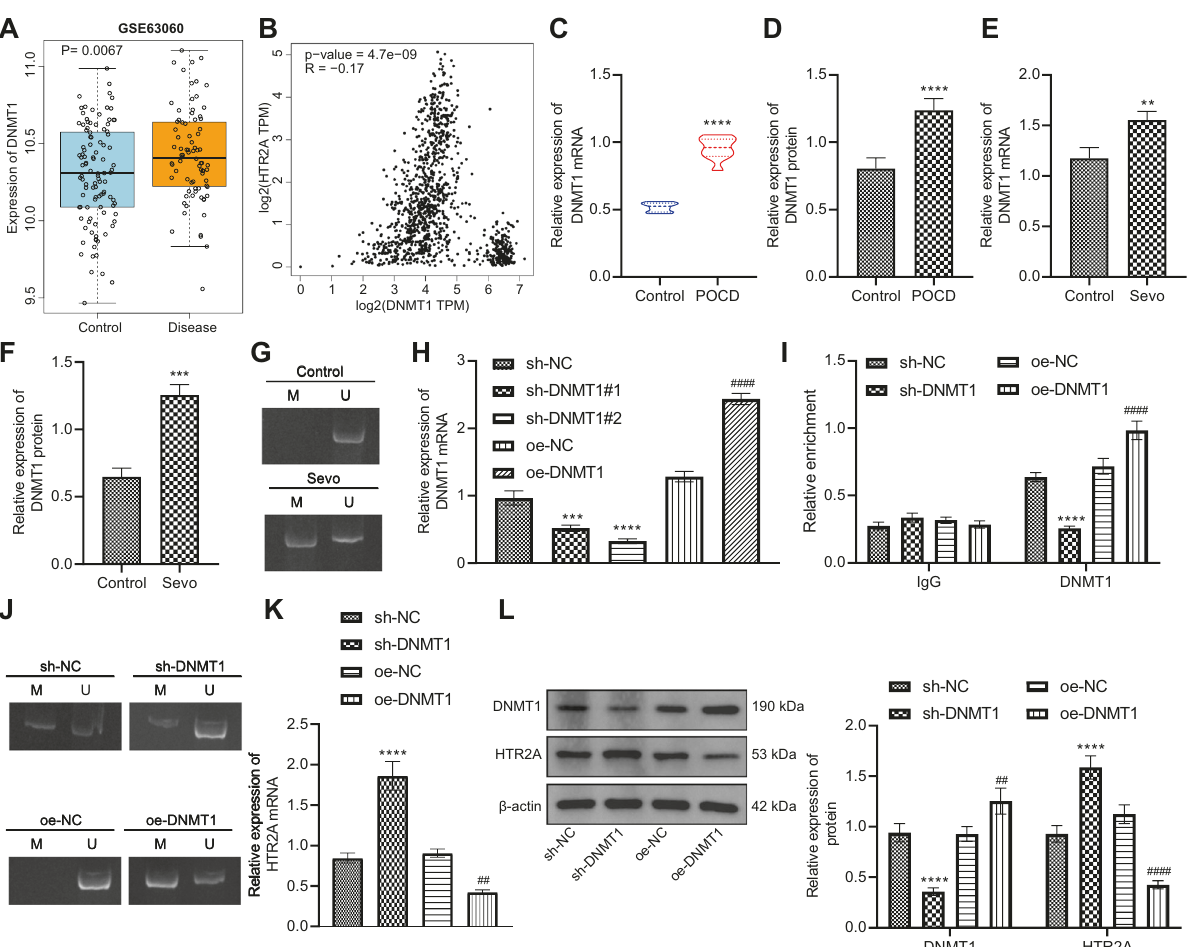
Fig. 4 DNA methyltransferase DNMT1 induces HTR2A methylation to repress its transcription in hippocampal neurons of POCD rats. A Expression of DNMT1 in POCD samples of GSE63060 (104 control samples and 80 POCD samples, * p < 0.05, ** p < 0.01, and *** p < 0.001 vs. control samples). B GEPIA database to analyze the expression of DNMT1 and HTR2A in brain tissue of GTEx. C Detection of expression of DNMT1 gene in the hippocampal tissues of rats after POCD modeling by RT-qPCR (* p < 0.05, ** p < 0.01, and *** p < 0.001 vs. the rats without POCD). D Western blot analysis of the protein expression of DNMT1 in the hippocampal tissues of rats after POCD modeling (* p < 0.05, ** p < 0.01, and *** p < 0.001 vs. the rats without POCD). E Detection of the ex p ression of DNMT1 gene in rat hippocampal neurons after Sevo treatment by RT-qPCR (* p < 0.05, ** p < 0.01, and *** p < 0.001 vs. the neurons without Sevo treatment). F Western blot analysis to detect the protein expression of DNMT1 in rat hippocampal neurons after Sevo treatment (* p < 0.05, ** p < 0.01, and *** p < 0.001 vs. the neurons without Sevo treatment). G MSP for measuring the methylation level of HTR2A promoter in hippocampal neurons after Sevo treatment. H RT-qPCR to determine the expression of DNMT1 gene in hippocampal neurons after sh-DNMT1 or oe-DNMT1 treatment (* p < 0.05, ** p < 0.01, and *** p < 0.001 vs. the neurons treated with sh-NC; # p < 0.05, ## p < 0.01, and ### p < 0.001 vs. the neurons treated with oe-NC). I Detection of enrichment of DNMT1 in HTR2A promoter by ChIP assay after sh-DNMT1 or oe-DNMT1 treatment. J MSP to detect the methylation level of